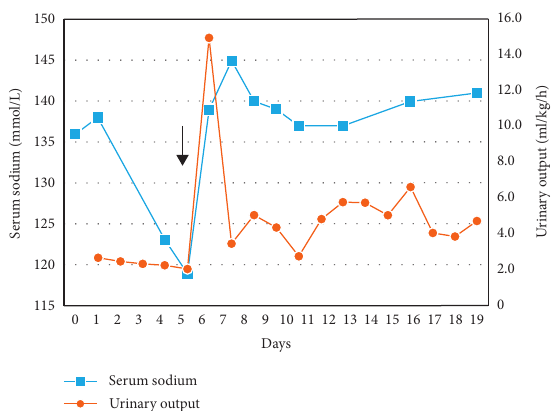
Figure 1: Serum sodium and urinary output before and after single-dose tolvaptan treatment. The black arrow indicates the day on which tolvaptan was